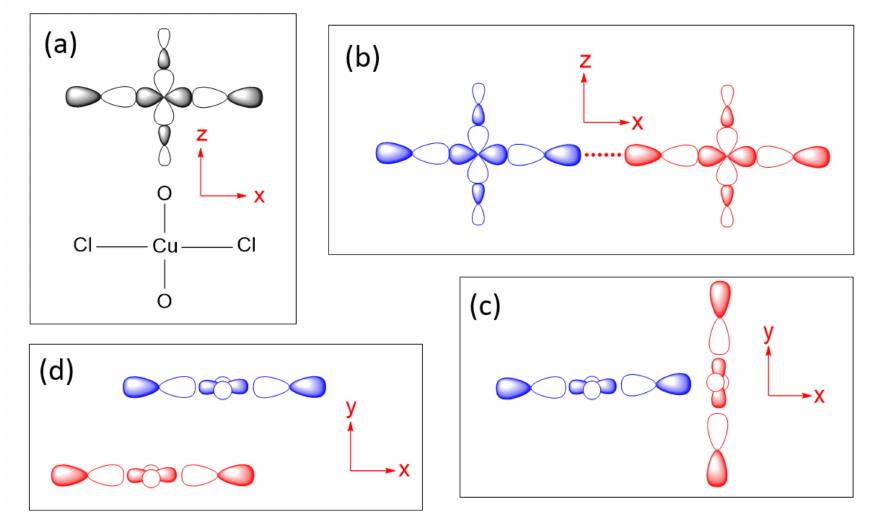
Figure 18. ( a ) The magnetic orbital lying in the CuCl 2 O 2 rhombus plane, which is best described as the x 2 –z 2 state. ( b – d ) Three different types of the magnetic orbital arrangements found in the CuClO 2 layers of orthorhombic CuCl(LaV 2 O 7 ). In this idealized representation of the CuCl 2 O 2 rhombus, the slight bending of the Cl–Cu–Cl linkage is neglected for